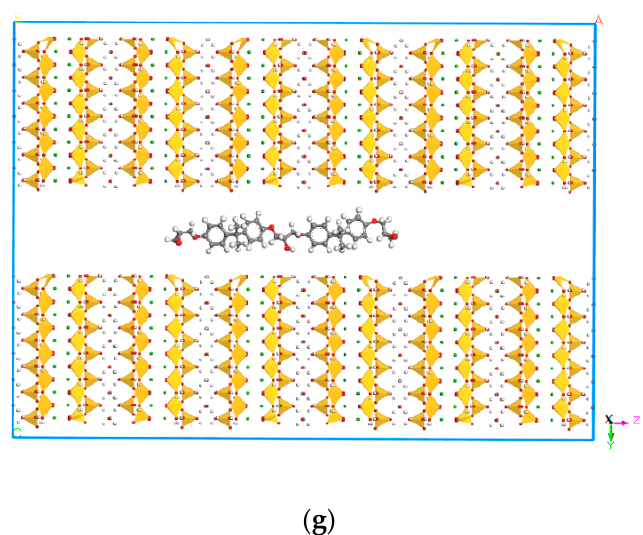
Figure 9. Molecular structures of the models. ( a ) Molecular structure of model 1. ( b ) Molecular structure of model 2. ( c ) Molecular structure of model 3. ( d ) Molecular structure of model 4. ( e ) Molecular structure of model 5. ( f ) Molecular structure of model. ( g ) Molecular structure of model 7.